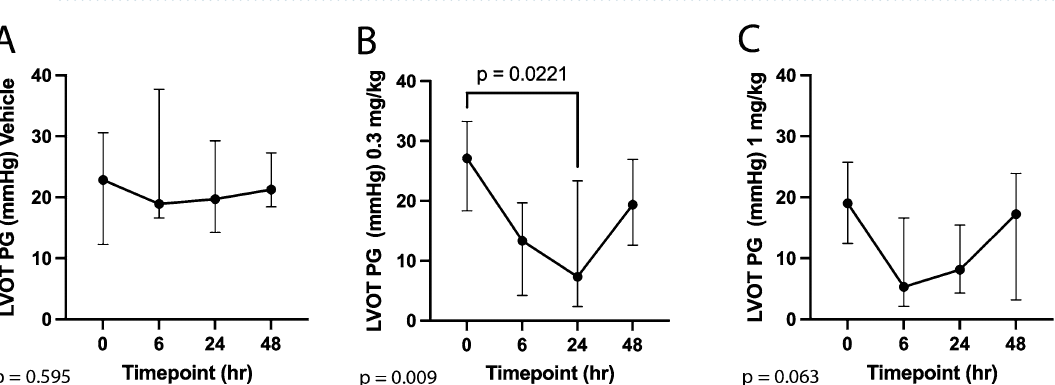
Figure 3. Left ventricular outflow tract peak pressure gradient (LVOT PG) at 6-, 24-, and 48-h post administration of treatment. ( A ) Vehicle. ( B ) Aficamten (0.3 mg/kg). ( C ) Aficamten (1.0 mg/kg). The median is denoted at each time point and the whiskers represent the interquartile range. The overall P value is denoted on the bottom left of each graph. Where pairwise comparisons were significant they are shown with their respective brackets and P